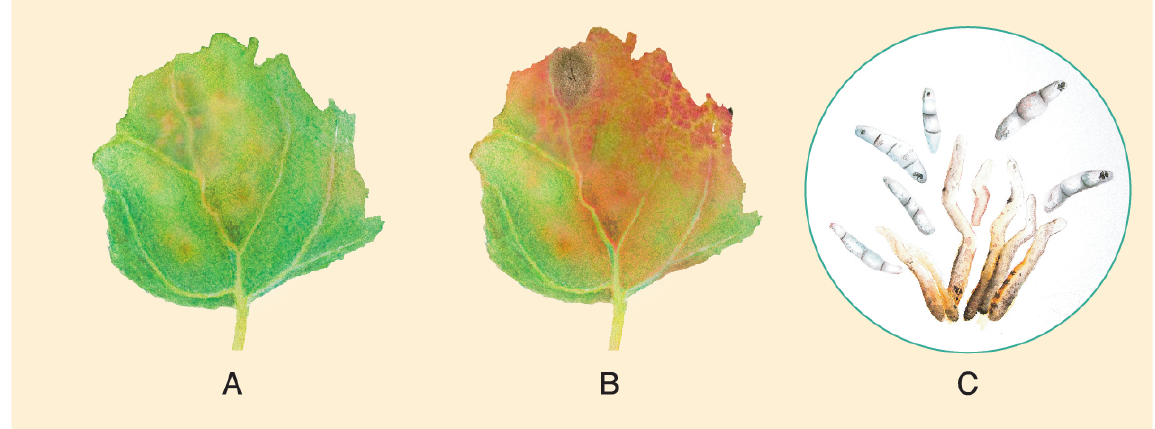
Figure 16. ( A , B ) Foliar symptoms of Cercospora leaf spot. ( C ) Condidia of Cercospora . Source: illustrations adapted from Yin et al. (2019)